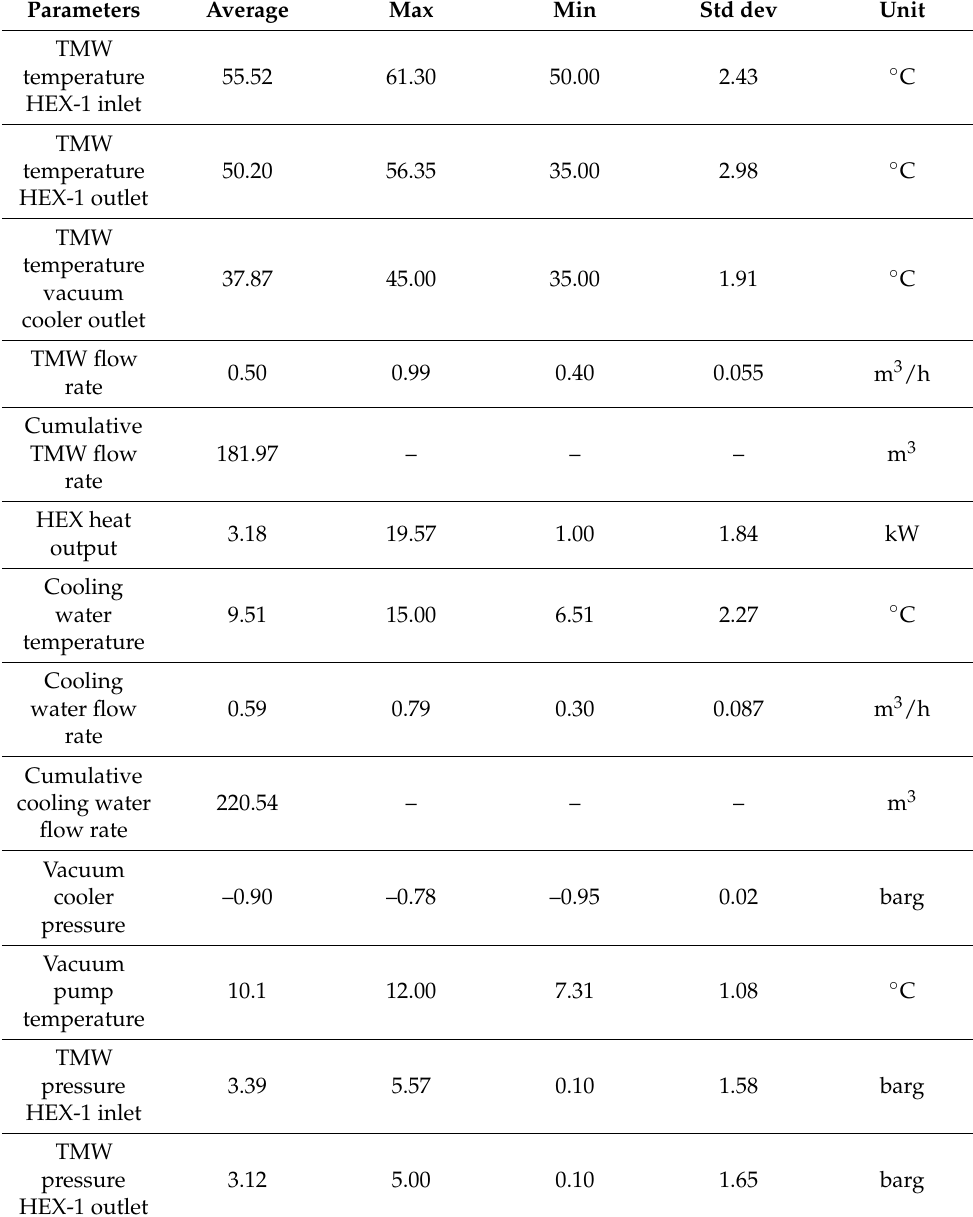
Table 4. Experimental data from cooling pilot